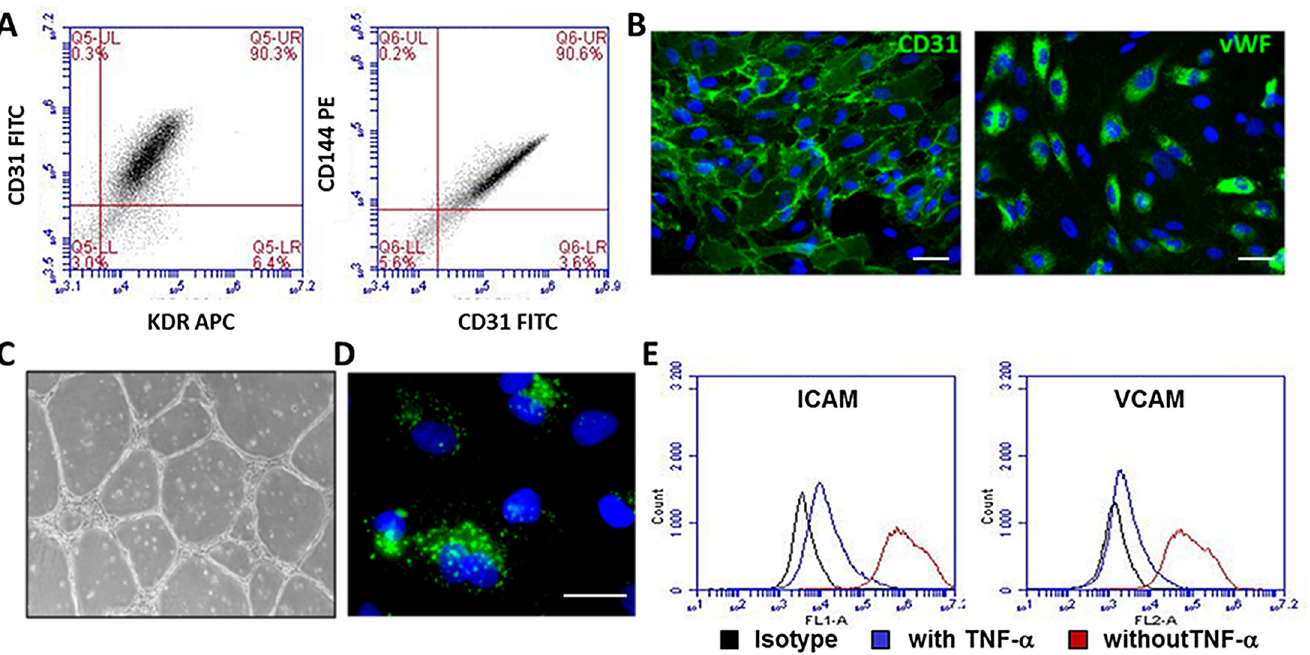
Fig 5. Phenotypic and functional characterization of iPSC-derived endothelial cells. (A) Expression of specific endothelial markers (KDR, CD31 and CD144) by flow cytometry at passage P4. (B) CD31 and vWF immunofluorescent staining at passage 5. Scale bars represent 50 μ m. (C) Vascular-like